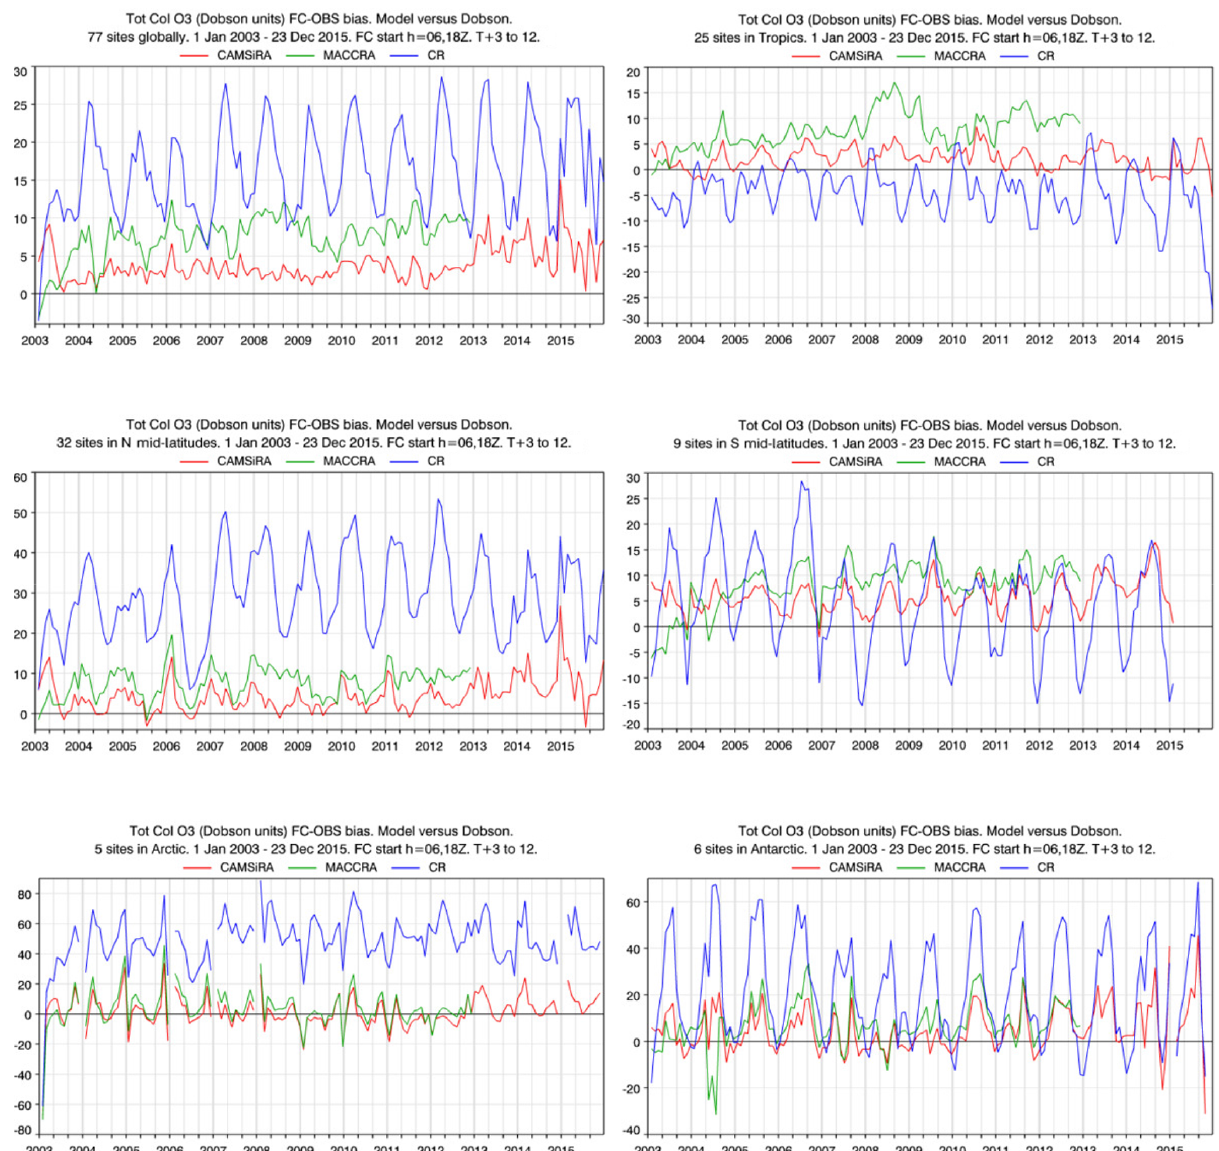
Figure 16. Time series of monthly mean bias inDU against WOUDC Dobson sun photometers for the globe (top left), the tropics (top right), NH mid-latitudes (middle left), SH mid-latitudes (middle right), the Arctic (bottom left) and Antarctica (bottom right) for CAMSiRA (red), the CR (blue) and MACCRA